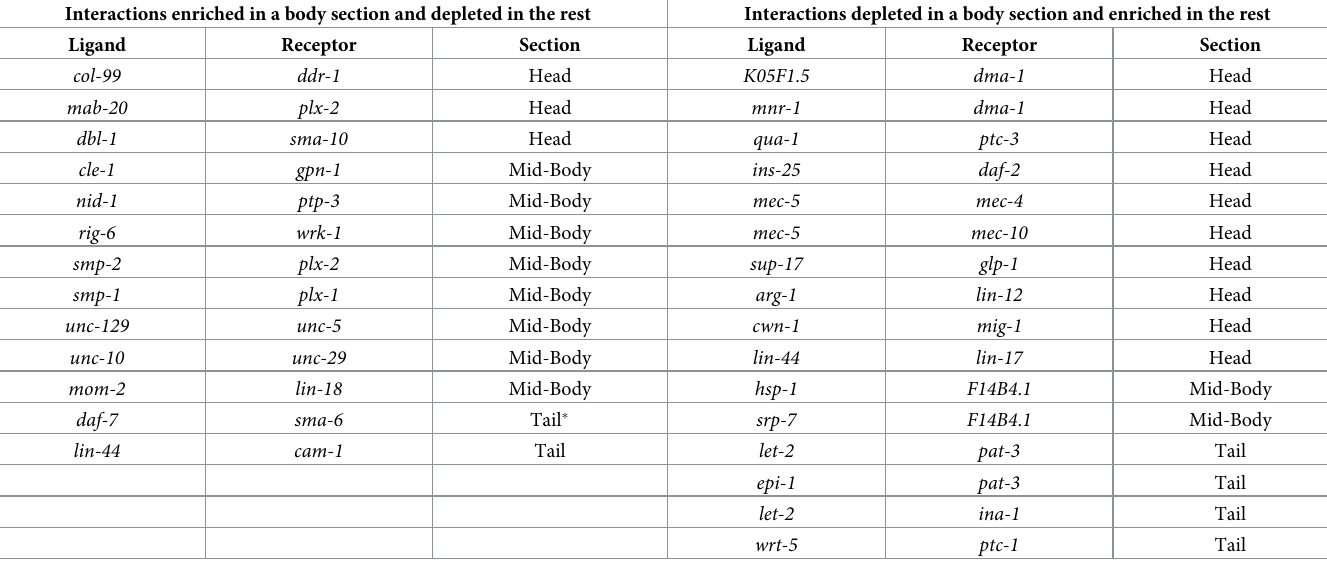
Table 1. Ligand-receptor interactions enriched or depleted in one body section and depleted or enriched in the rest. Interactions enriched in a body section and depleted in the rest Interactions depleted in a body section and enriched in the rest Section